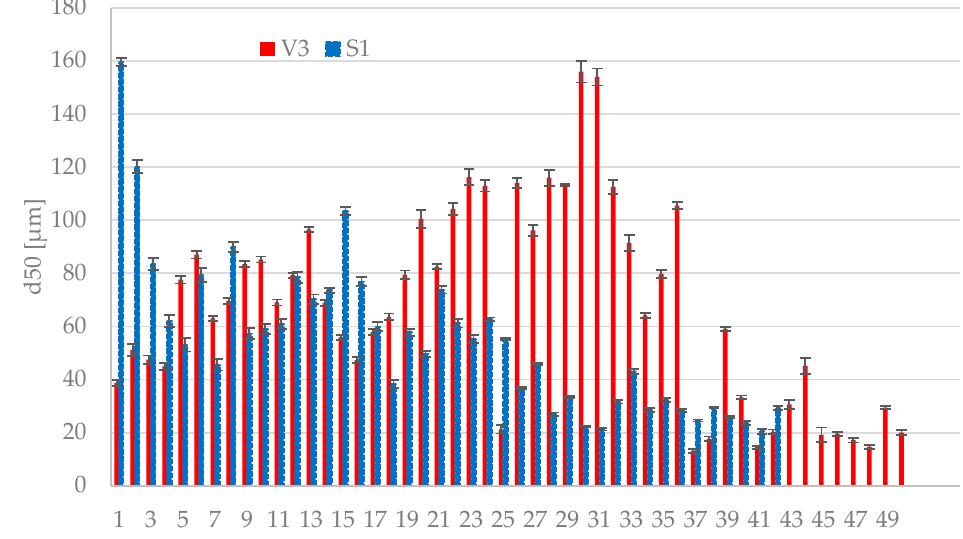
Figure 3. Mean Particle Size of Deposited Ash from Core Borehole V3 and Bottom Ash from Core Borehole S1.